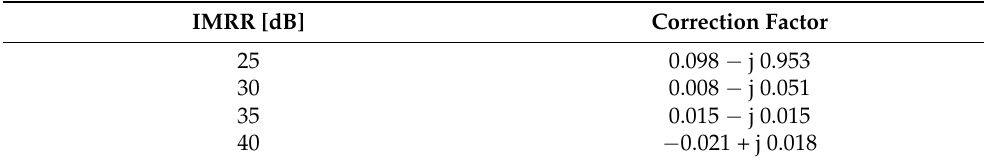
Figure 4. IMRR variation with respect to the correction factor for USRP X310 platform. Table 4. Considered IMRR values and the corresponding correction factors.